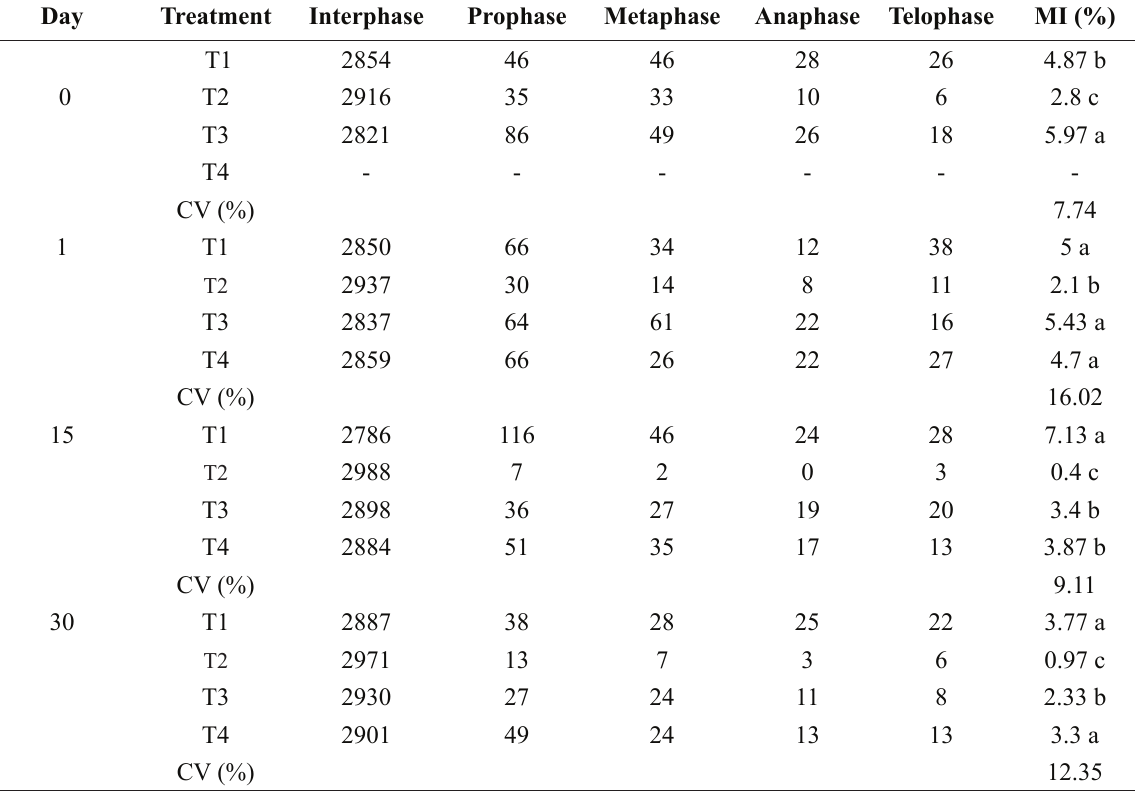
Number of Allium cepa cells at the interphase and mitosis stages. Santa Maria, 2014. Day